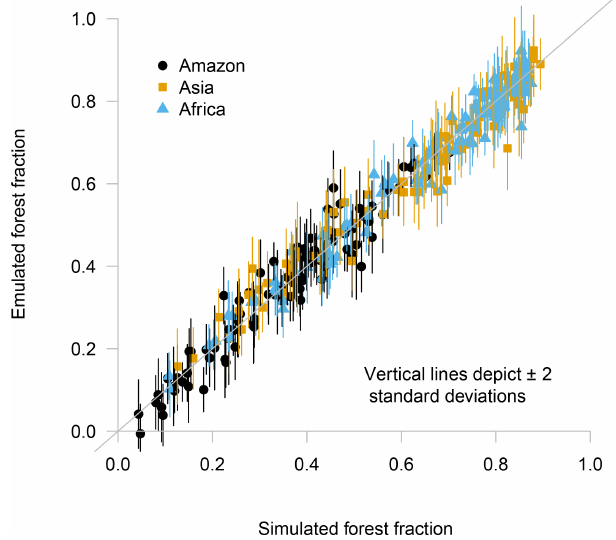
Figure 6. Leave-one-out cross-validation plot, with the true value of the simulator output on the x axis and predicted output on the y axis. Vertical lines indicate ± 2 standard